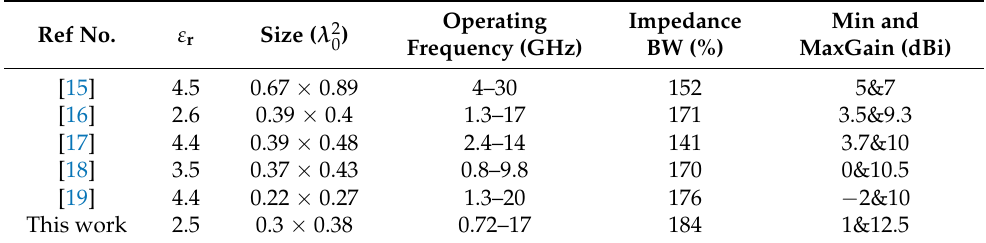
Table 2. Comparison between some AVAs and TSAs (tapered slot antennas) in literature and the proposed antipodal Vivaldi antenna. Ref